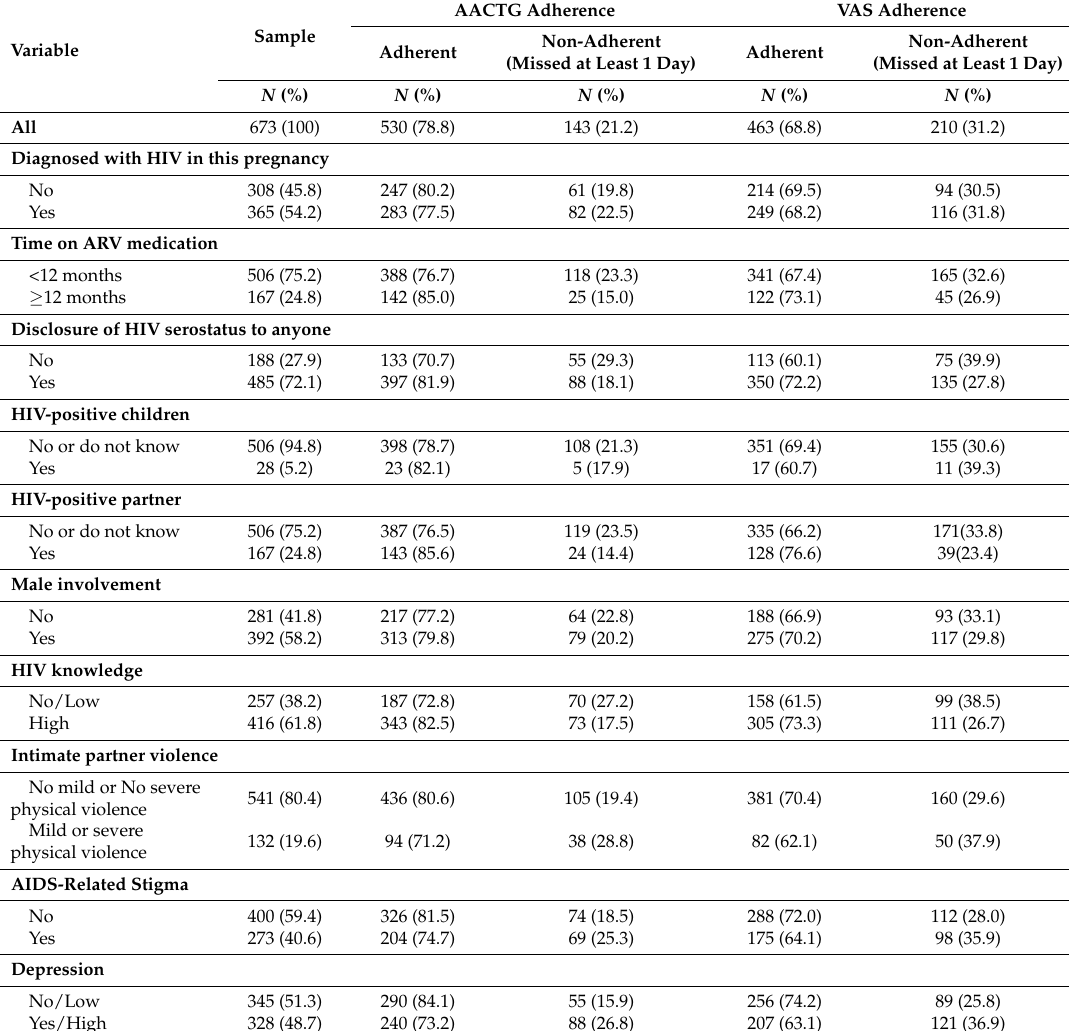
Table 2. Health and behaviour